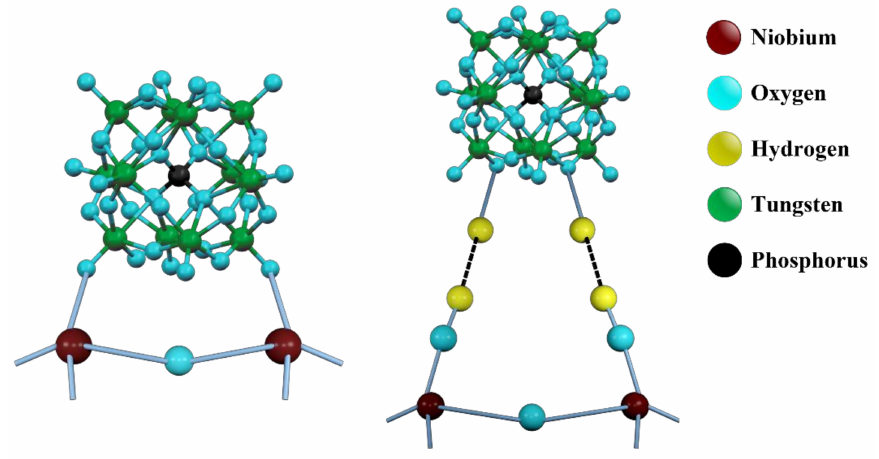
Figure 26. Supported 12-tungstophosphoric acid on Niobium oxide (adapted from [83]). H 3 PW 12 O 40 /Nb 2 O 5 catalysts were used in transesterification reactions of waste cook-